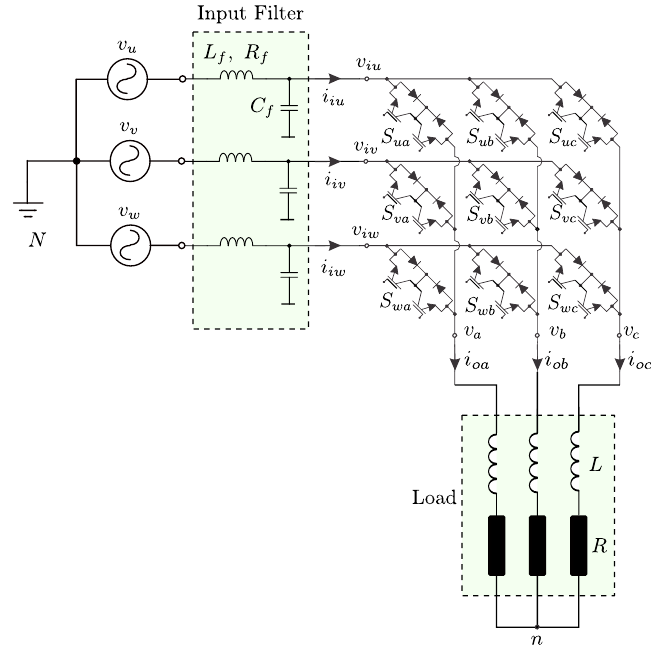
Figure 5. Three-phase direct matrix converter feeding an RL